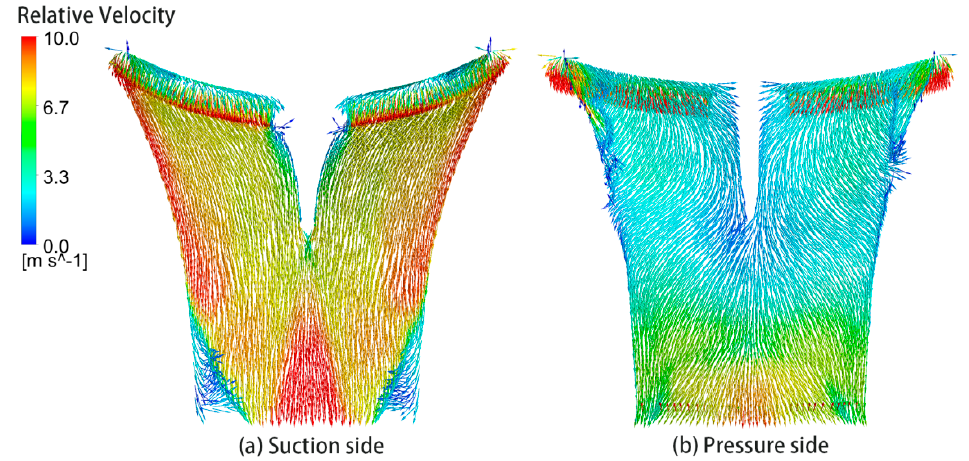
Figure 7. Relative velocity of water around the blade surface (units: m/s, silt size: 0.04 mm, silt concentration: 10 kg/m 3 ).